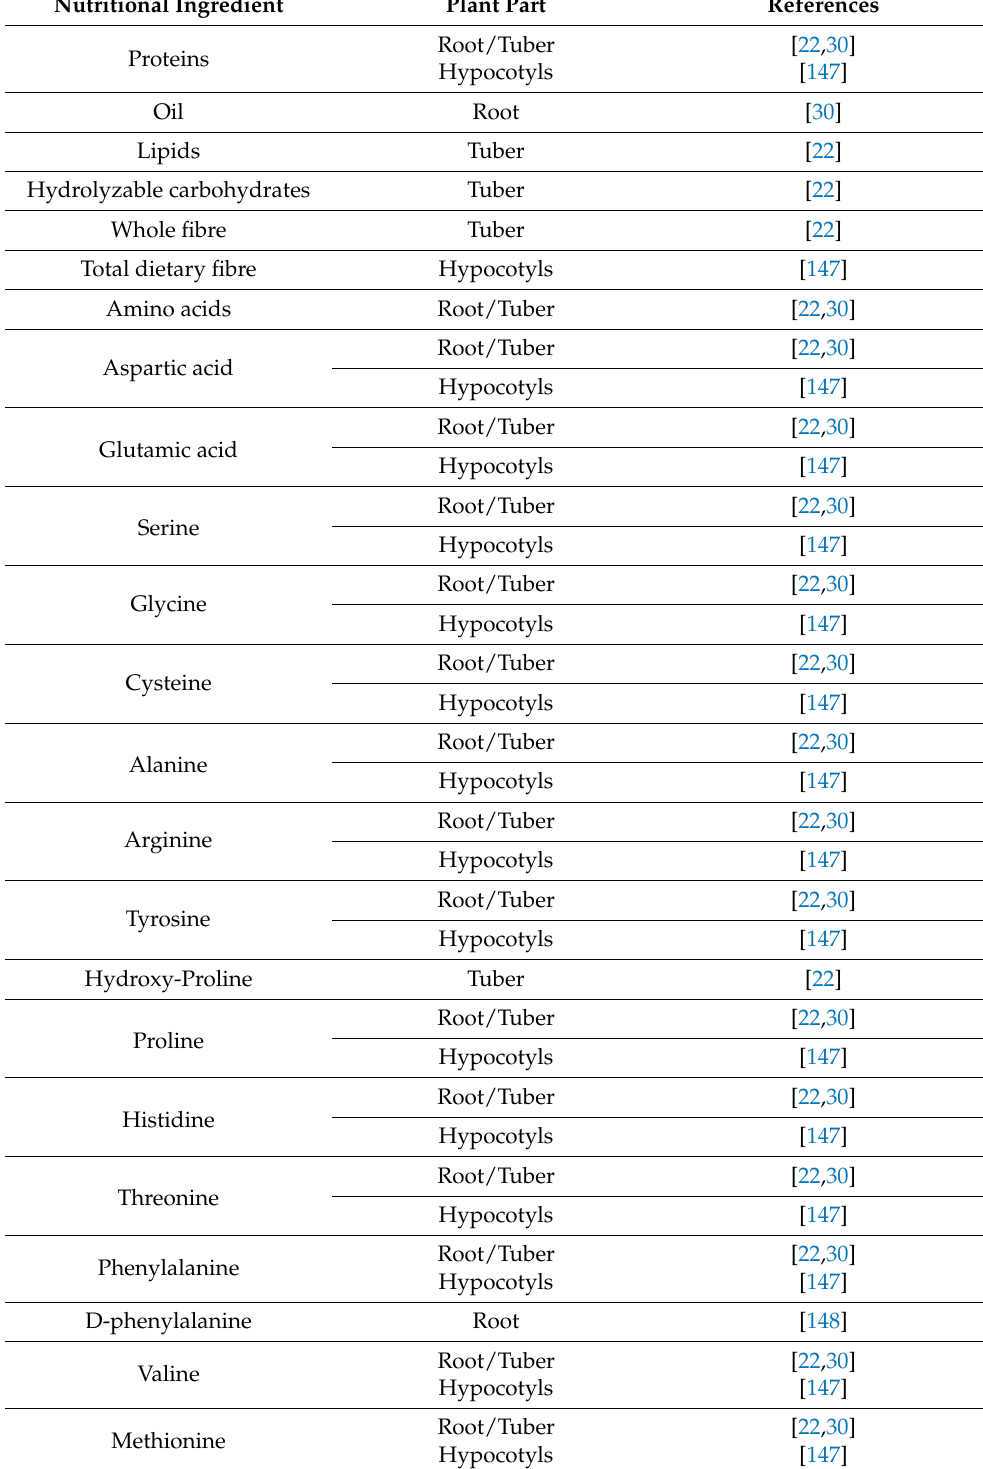
Table 3. Nutritional ingredients in Lepidium meyenii